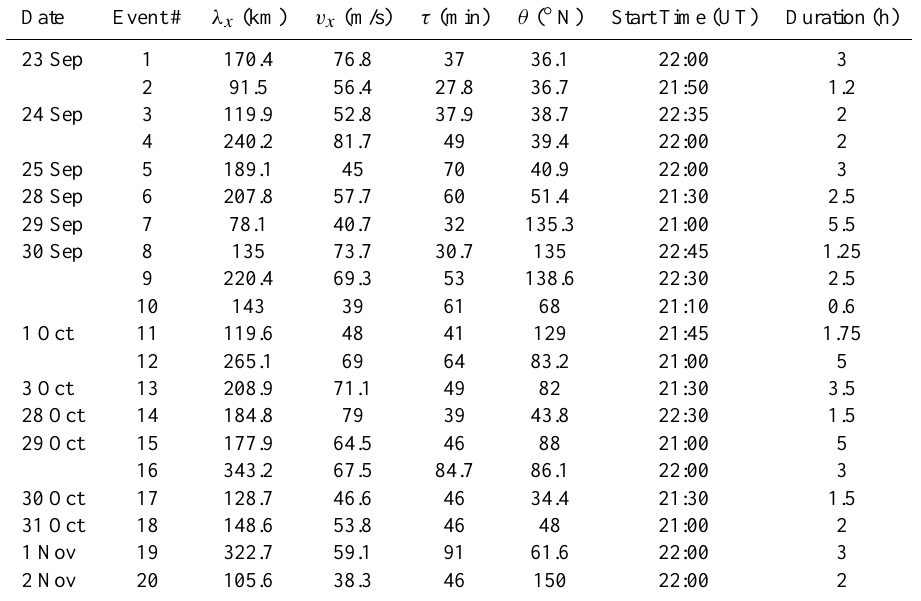
Table 2. Summary of medium-scale waves observed over Cariri. The estimated uncertainties are ± 10% for the wave